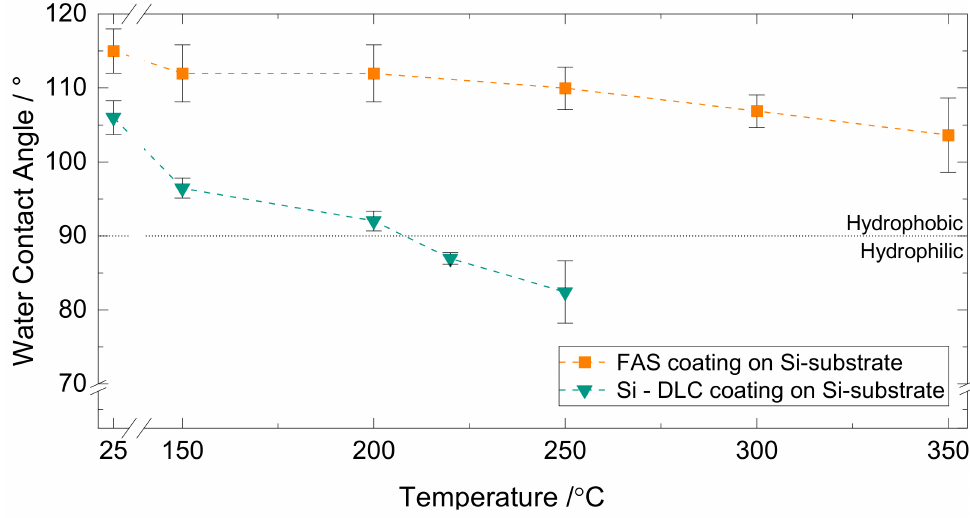
Figure 10. Comparison of the thermal resistance of the different coatings on a silicon substrate.